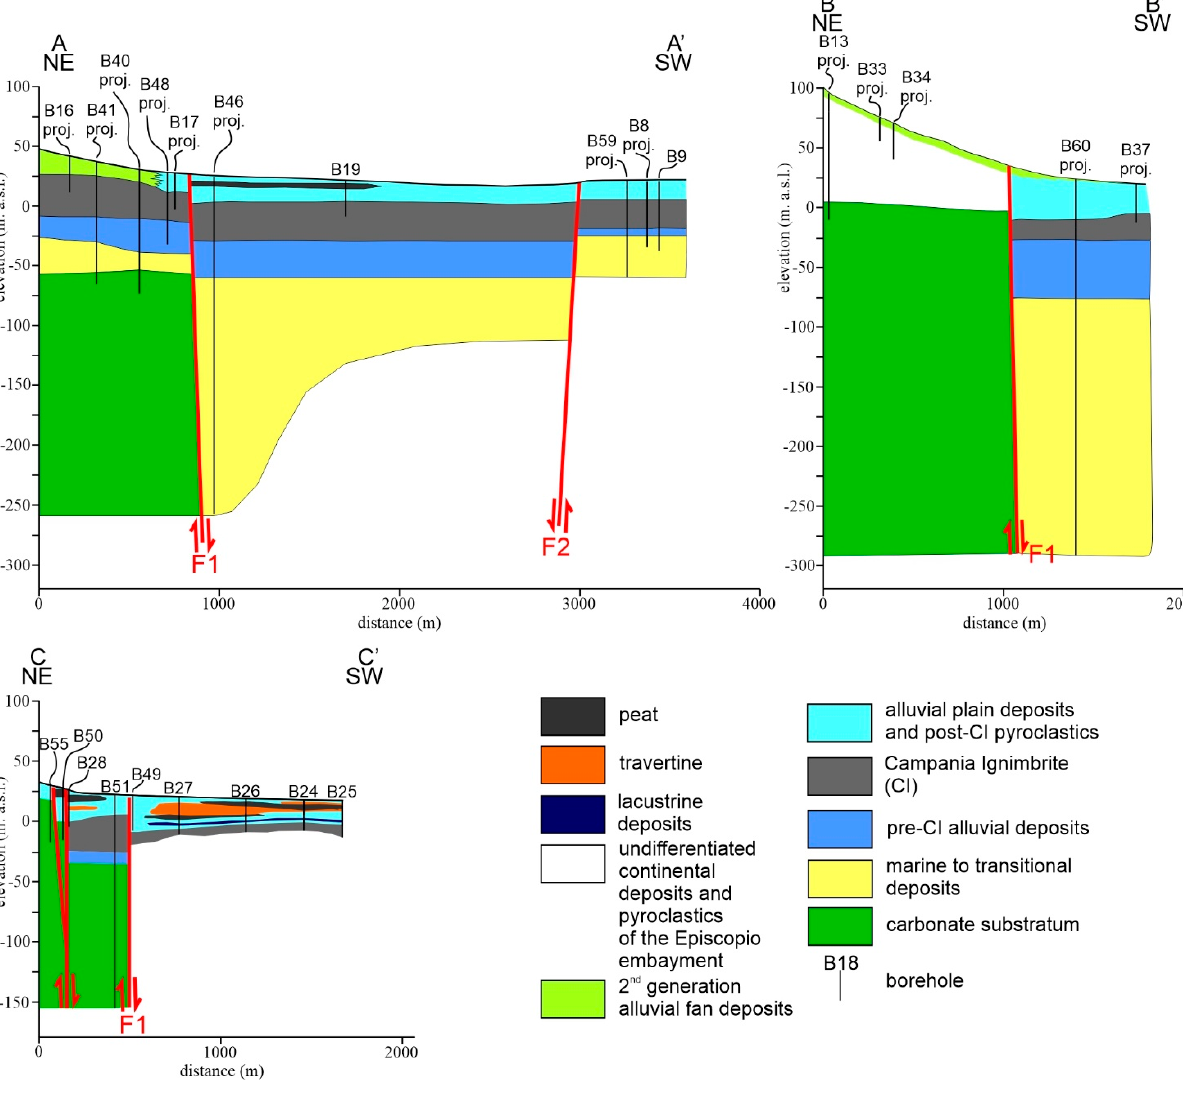
Figure 5 . Geological cross-section showing the spatial distribution of the Quaternary marine, continental, and volcanic deposits and the pre-Quaternary carbonate substratum. Cross-section traces are reported in Figure 4. Cross-section A − A’ is centred in the Lavorate embayment and it is modified from Valente et al. [20]. Cross-section B − B’ is centred in the Episcopio embayment; cross-section C − C’ is centred in the Sarno urban area.